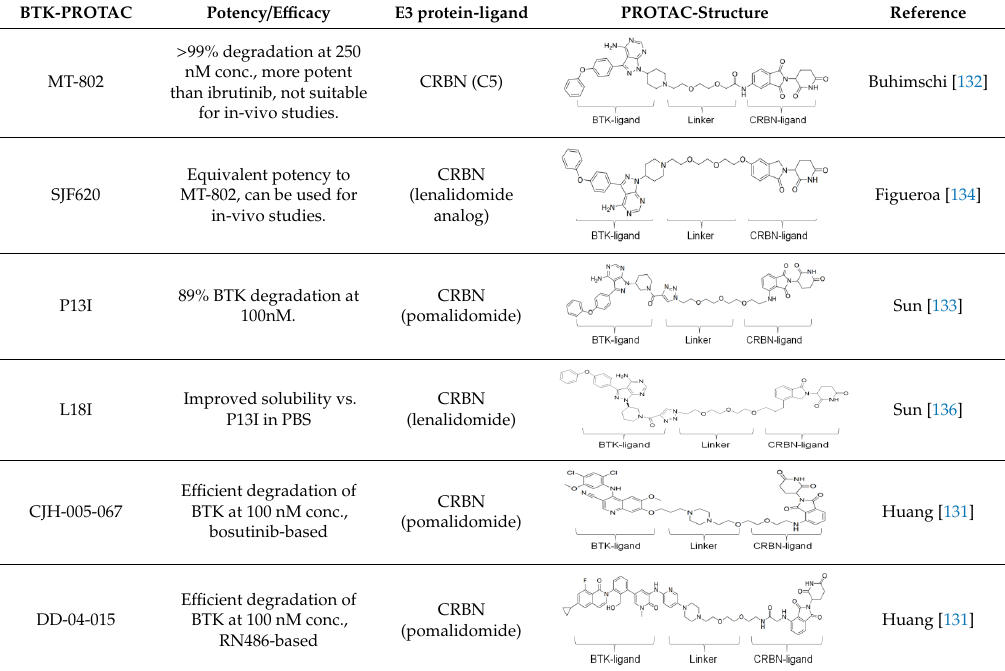
Table 3. List of BTK-PROTAC currently under investigation.